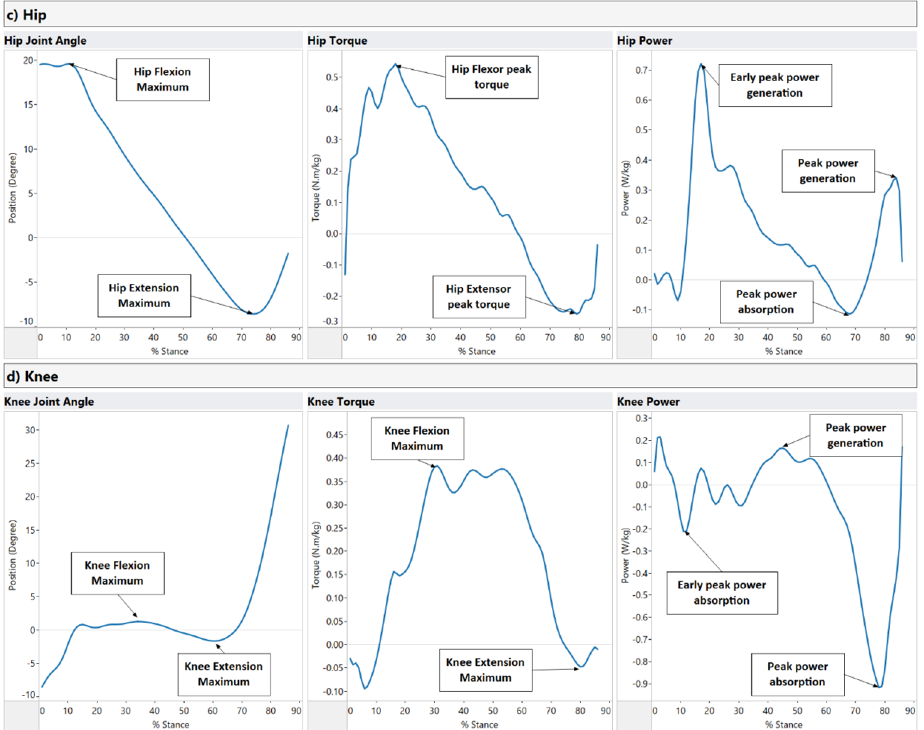
Figure A1. Gait features extracted from raw biomechanics data. ( a ) Ground reaction forces (GRF) raw signals and the peak points extracted, ( b ) Ankle, ( c ) Hip, and ( d ) Knee raw signals with the peak points extracted.